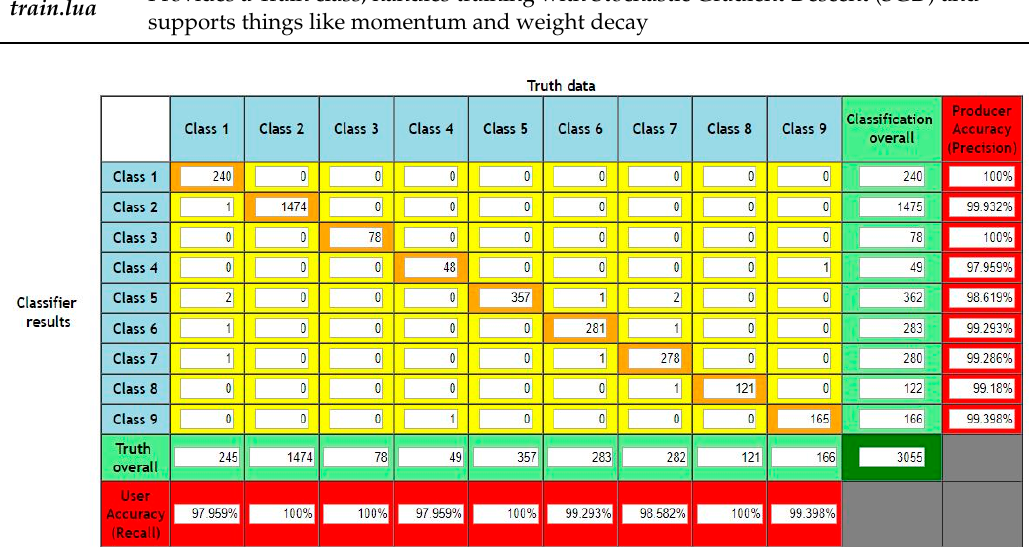
Figure A1. Confusion matrix, precision, and recall values for all classes.